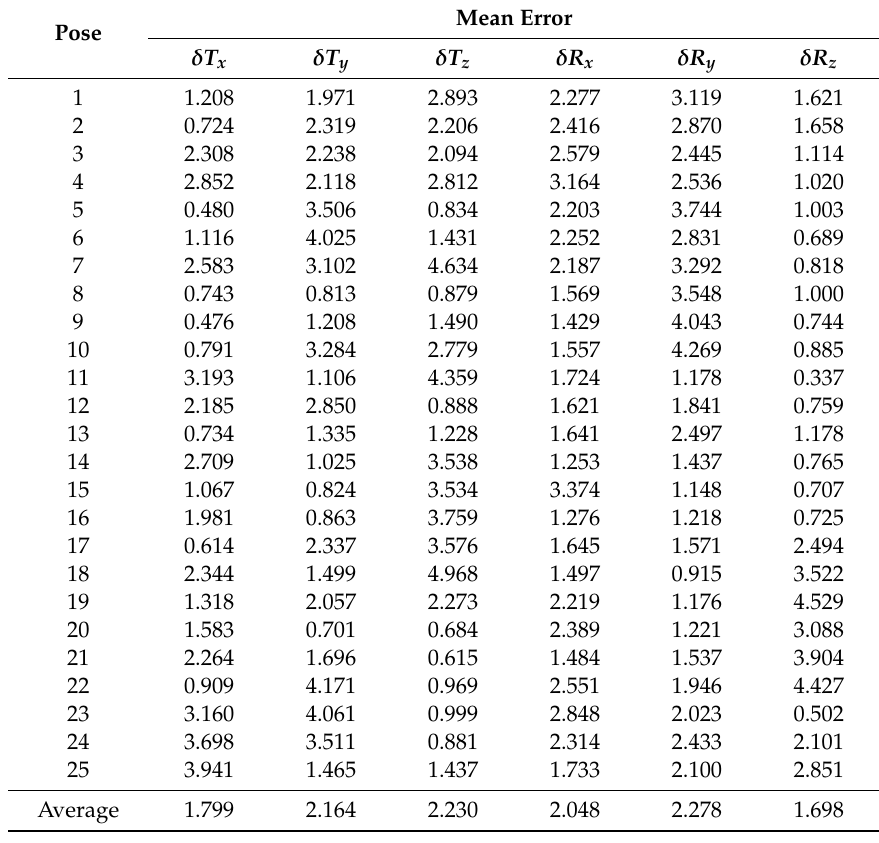
Table 4. Absolute error per pose, with 20 tests per pose for the back side. Results in mm for translation error and in degrees for rotation